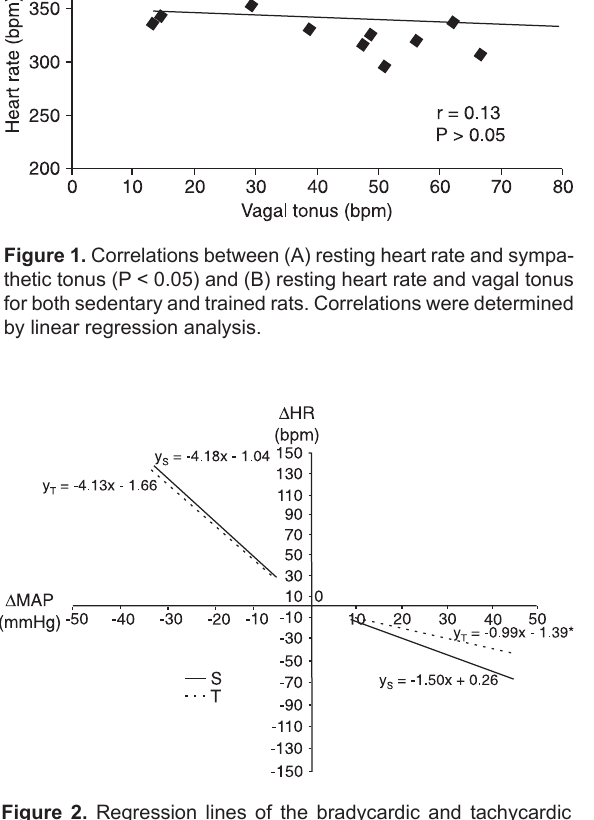
Figure 2. Regression lines of the bradycardic and tachycardic response to pressor changes induced by increasing doses of phenylephrine and sodium nitroprusside in sedentary (S) and trained (T) female rats (P < 0.05 vs S). HR = heart rate; MAP = mean arterial pressure. Correlations were determined by linear regression analysis.